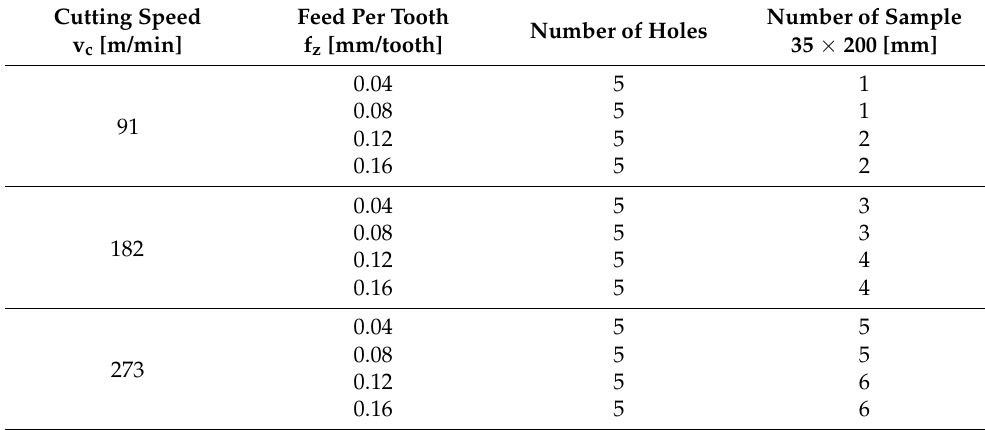
Figure 5. Equipment used for drilling: ( a ) vertical machining center Avia VMC800HS, ( b ) carbide- diamond-coated drill, ( c ) Kistler dynamometer. Table 2. Technological parameters of the GFRP composite drilling.